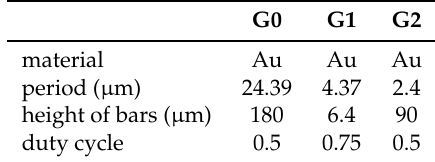
Table 2. Parameters of the